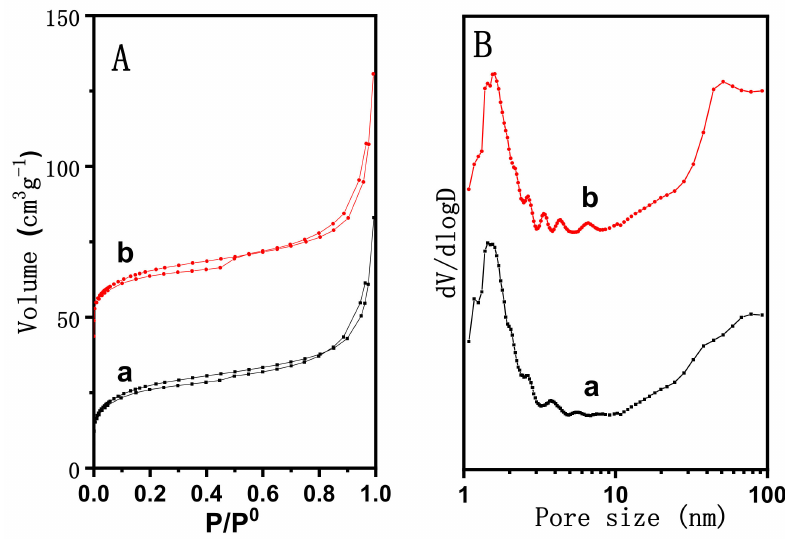
Figure 3. ( A ) Nitrogen adsorption-desorption isotherms and ( B ) pore size distribution curves of (a) CeO 2 -NS and (b) Pt/CeO 2 -NS.